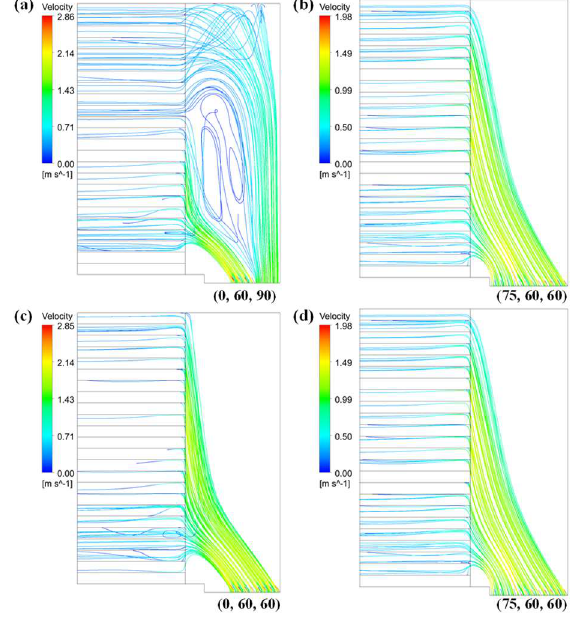
Figure 12. Streamlines of ( a ) F1, ( b ) F4, ( c ) F7, and ( d ) F10.